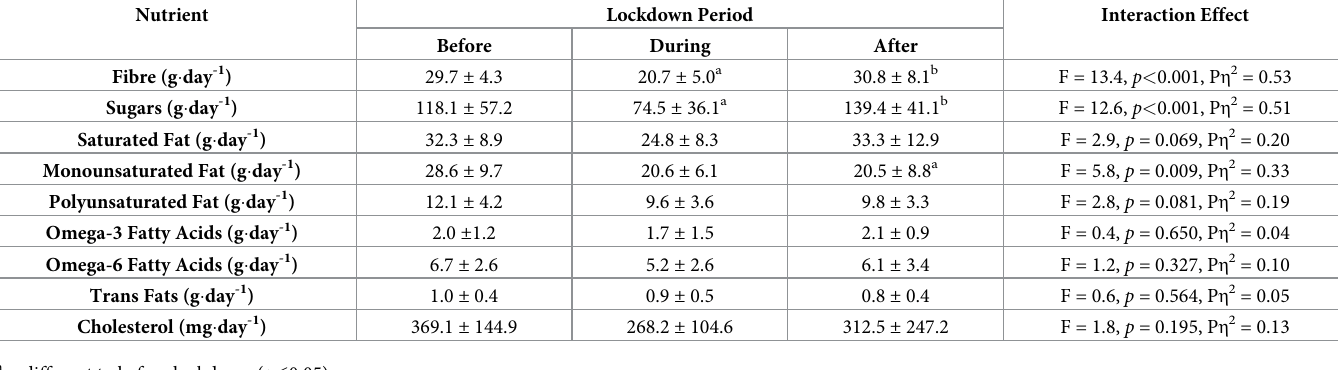
Table 3. Carbohydrate and lipid components recorded in the diets of highly trained adolescent swimmers before, during, and after the COVID-19 lockdown. Nutrient Lockdown Period Interaction